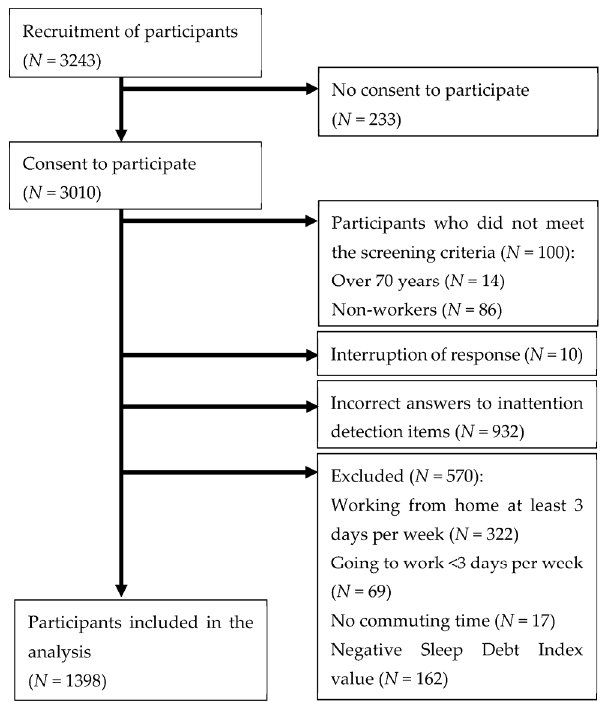
Figure 2. Flowchart of participant selection.